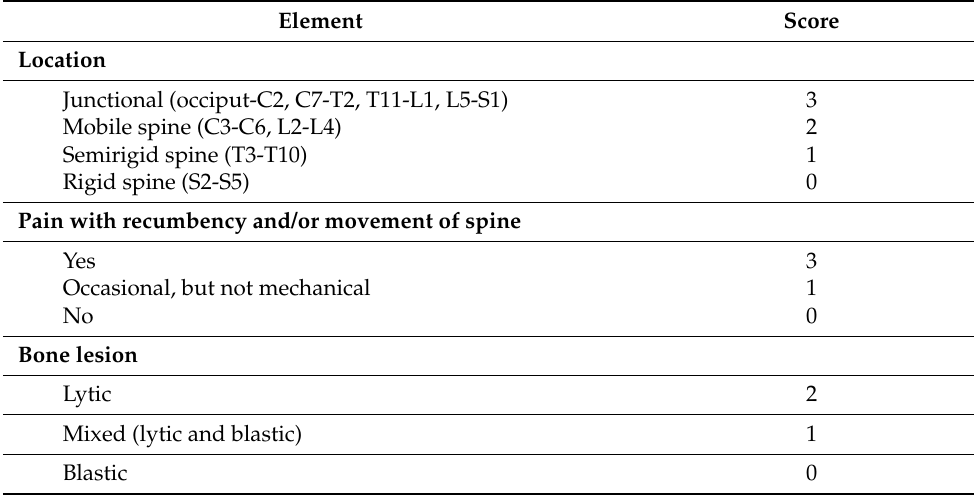
Table 4. Spine instability neoplastic scoring (SINS). Adopted from reference [54] Fisher, C.G.; DiPaola, C.P.; Ryken, T.C.; Bilsky, M.H.; Shaffrey, C.I.; Berven, S.H.; Harrop, J.S.; Fehlings, M.G.; Boriani, S.; Chou, D.; et al. A novel classification system for spinal instability in neoplastic disease: an evidence-based approach and expert consensus from the Spine Oncology Study Group. Spine 2010 , 35 ,